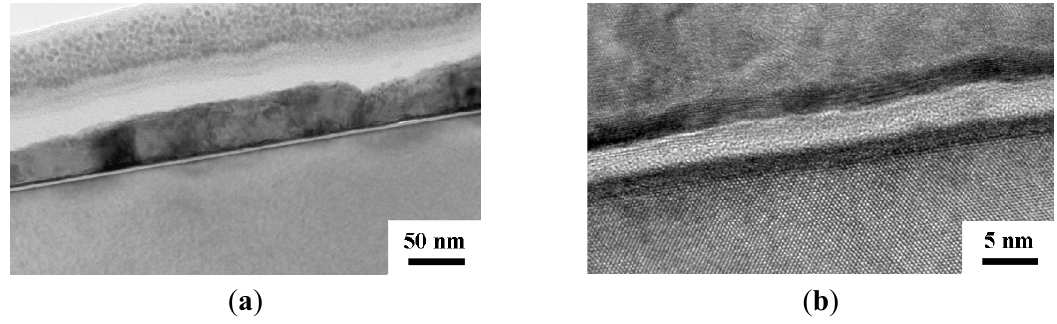
Figure 5. TEM cross section views for the structures of MgO (3 nm) sample annealed for 5 min at 500 °C at a relatively low magnification ( a ); and at a relatively high magnification ( b ).